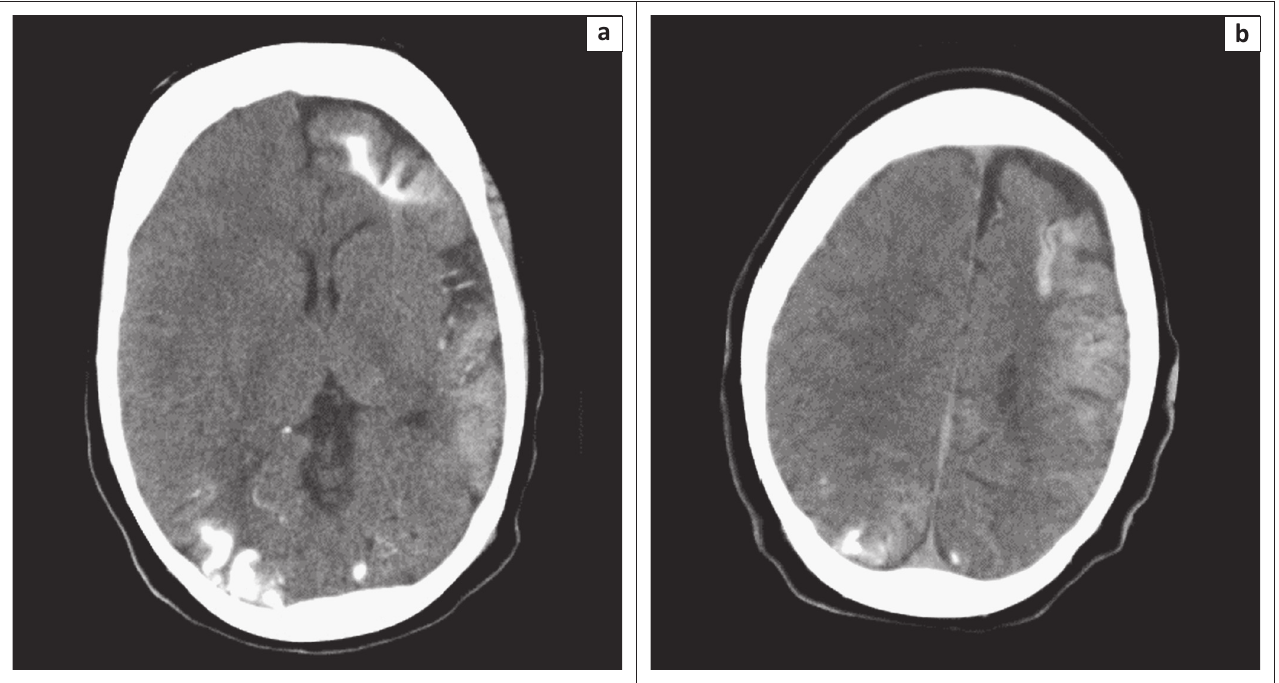
FIGURE 1: Axial nonenhanced computed tomography (NECT) at two levels, (a) and (b), demonstrating the radiological hallmark of curvilinear calcification following a gyral pattern.